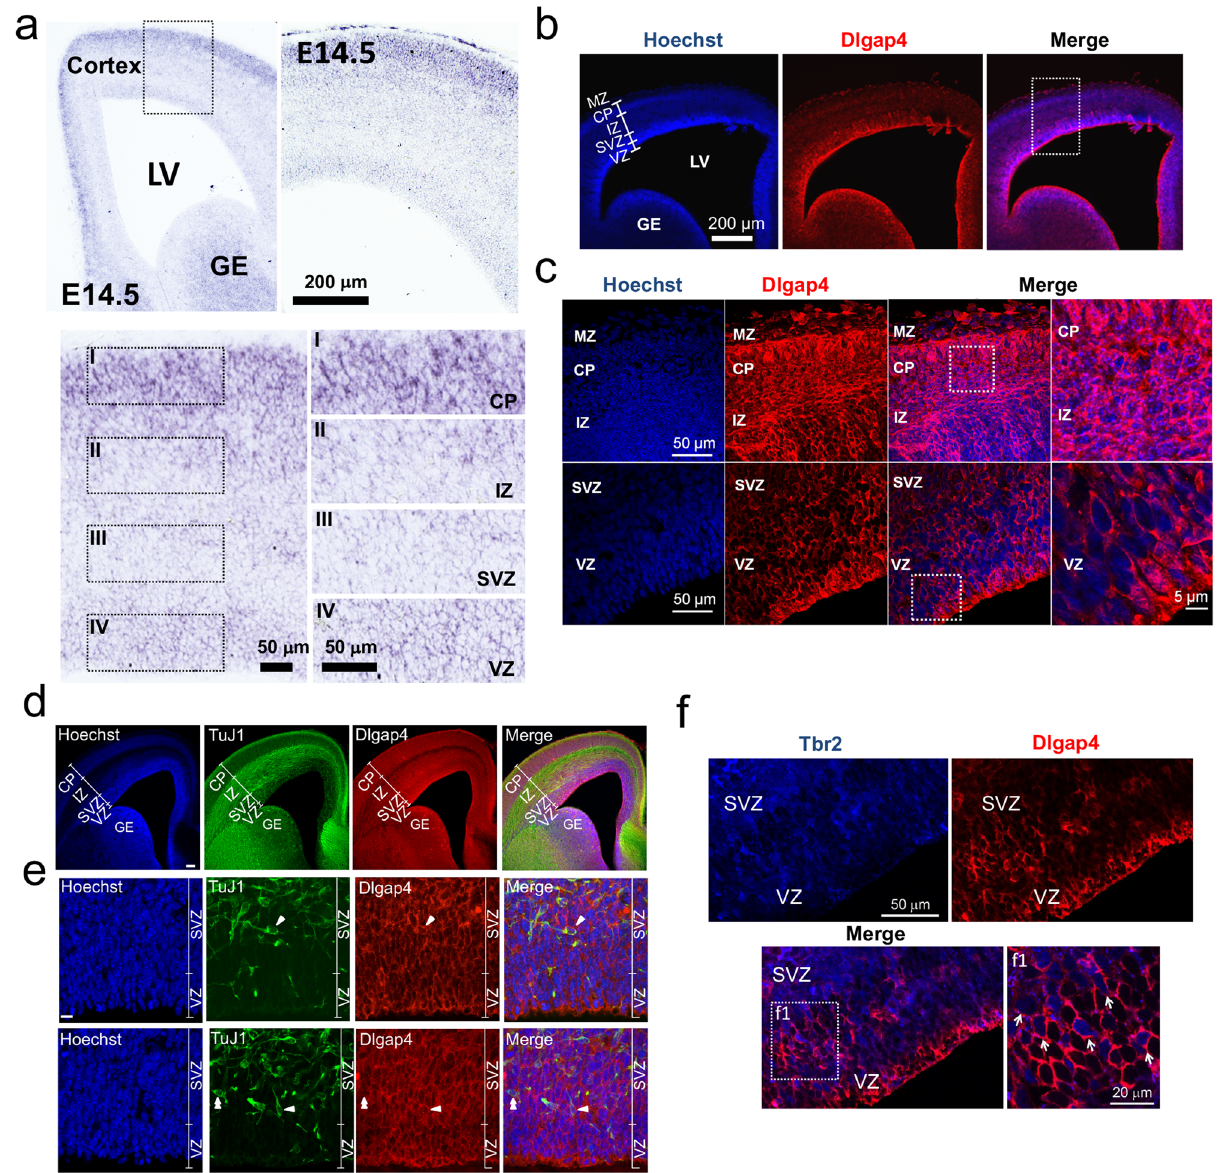
mouse cortical wall. Coronal sections are shown. Representative immuno fl uorescence images showing, Dlgap4 (red) and Hoechst staining (blue) coronal sections at E14.5, at lower ( b ) and higher ( c ) magni fi cation. Images correspond to 10 μ m stack projections. LV: lateral ventricle, VZ: ventricular zone, SVZ: sub-ventricular zone, IZ: intermediate zone, CP: cortical plate, MZ: marginal zone, GE: ganglionic eminence. d Co-labeling between Dlgap4 and class III beta in expression in the axons, although high co-labeling in the cell bodies (higher magni fi cation). Arrowheads indicate individual neurons ( f ) Co-labeling between Dlgap4 (red) and the intermediate progenitor marker Tbr2 (blue) shows Dlgap4 expression in the soma at E14.5 mouse brain. Z-stack 1 μ m thickness and single confocal plane with higher magni fi cation in far-right panel ( f1 ). Arrows indicate individual cells with Tbr2 and Dlgap4 double